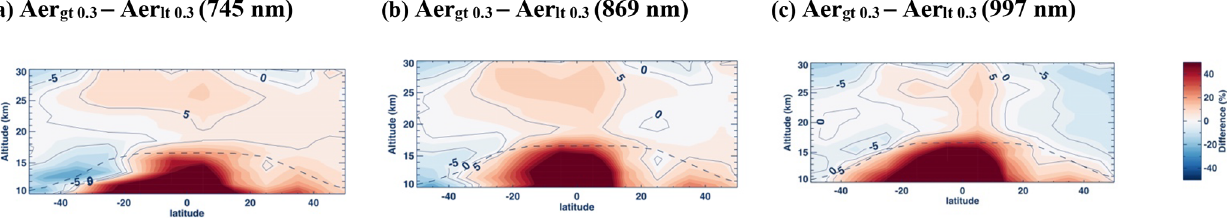
Figure 4. Panels (a) through (c) show the difference between the aerosol climatology when reflectivity is greater than 0.3 and when reflectivity is less than 0.3. Extinction climatology at 745, 869 and 997nm. The dashed line is tropopause altitude. The contour line shows differences greater than ± 5%.